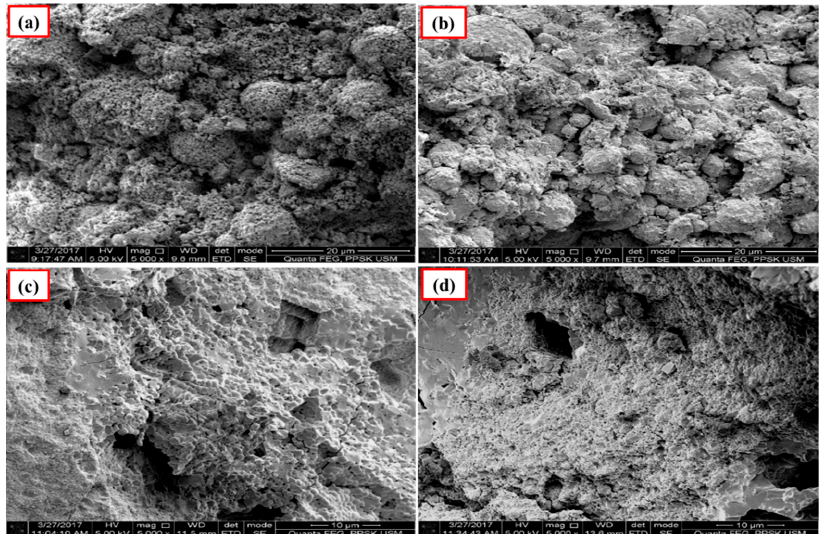
Figure 4. SEM images of the unpolished Ca-SZ(CS) sintered for 2 h at ( a ) 1200 °C; ( b ) 1300 °C; ( c ) 1400 °C and ( d ) 1500 °C.